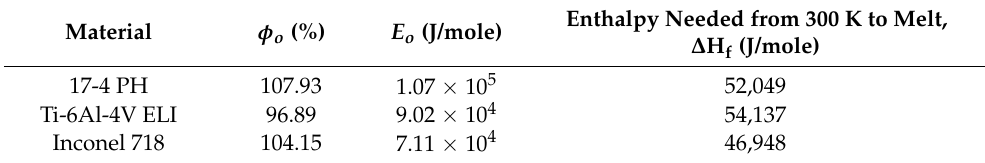
Table 4. φ o and E o of 17-4 PH, Ti-6Al-4V ELI and Inconel 718.